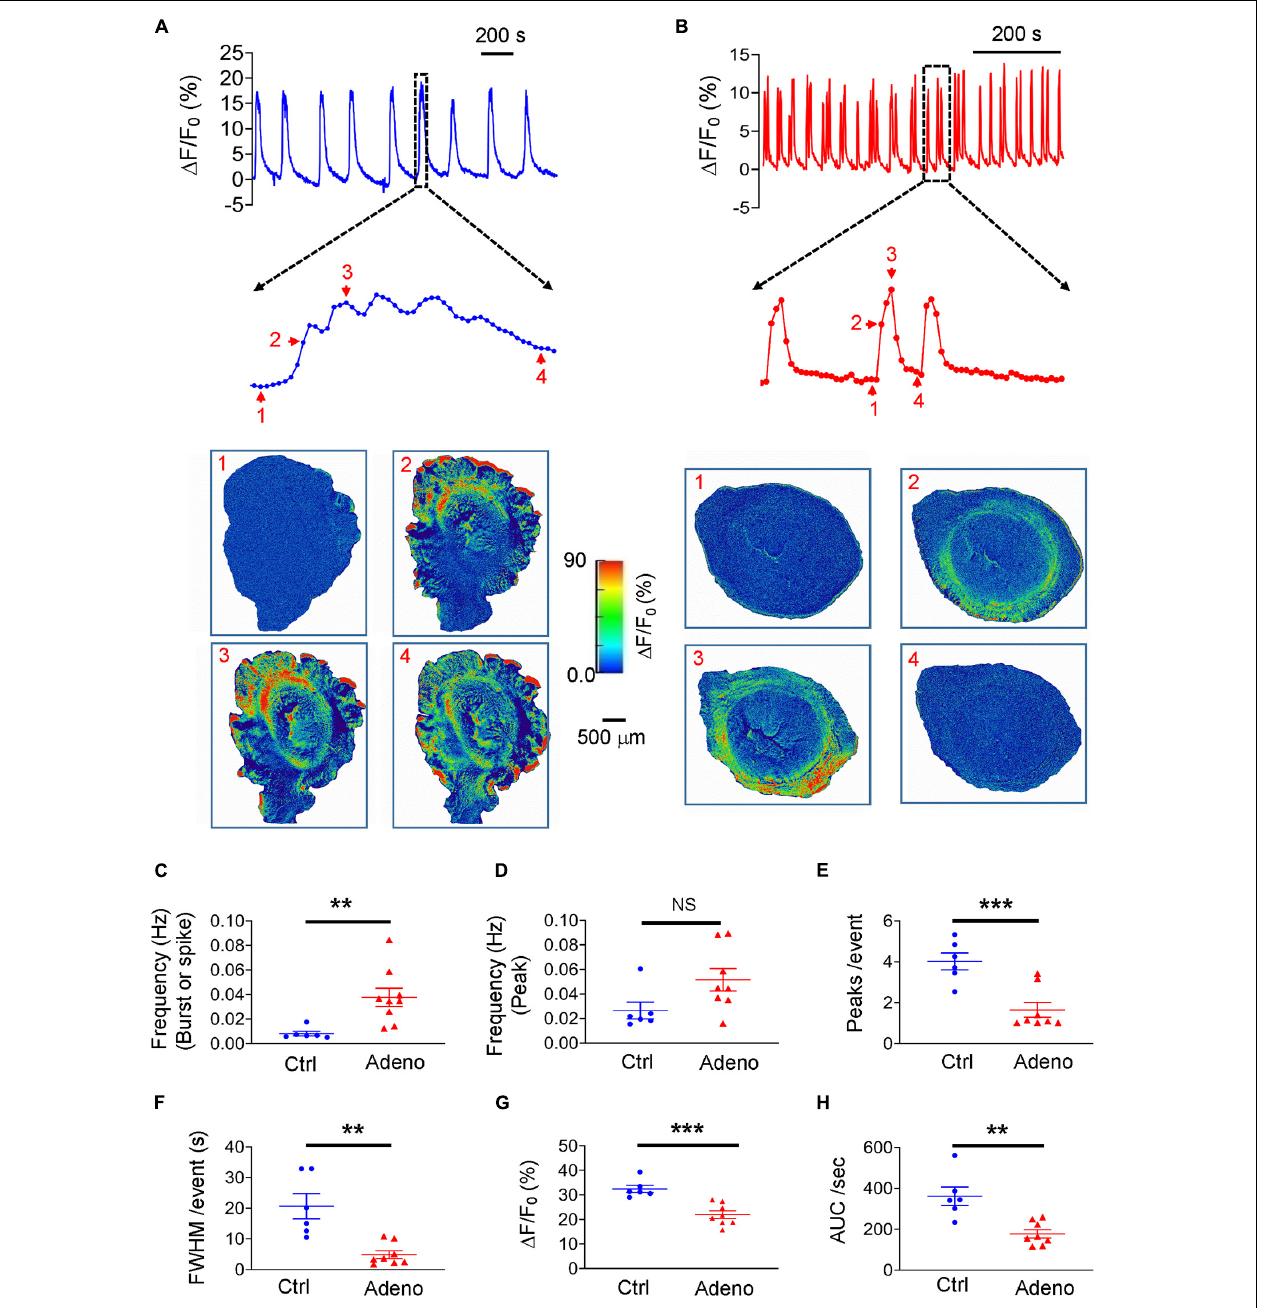
FIGURE 6 | Changes in Ca 2 + oscillations in adult adenomyotic mice. (A) Typical Ca 2 + oscillations in postnatal day (PND) 55 mice after treatment with the vehicle for tamoxifen (Ctrl). A burst event as marked with the dotted line box is shown in an expanded time scale, and images below the trace are snapshots of this event as indicated by the corresponding numbers near the trace. (B) Typical Ca 2 + oscillations in PND55 mice after treatment with tamoxifen. Three events as marked with the dotted line box are shown in an expanded time scale, and images below the trace are snapshots of one of these events, as shown by the corresponding numbers near the trace. (C) Ca 2 + oscillation frequency when a burst or a spike was counted as one event (the same convention is applied to panels E–H ). (D) Ca 2 + oscillation frequency when an individual peak in bursts or spikes was counted as an event. (E) Numbers of Ca 2 + oscillations per event in uterine slices from Ctrl and Adeno mice at PND55. (F) Full width at half maximum (FWHM)/event in uterine slices from Ctrl and Adeno mice at PND55. (G) Amplitude of Ca 2 + oscillations in uterine slices from Ctrl and Adeno mice at PND55. (H) Calcium intensity (AUC × Frequency) in uterine slices from Ctrl and Adeno mice at PND55. Note that each data point in panels (C–H) is an average value from multiple slices in a mouse, and each slice was recorded for 30 min. N.S., no statistical significance, ** P < 0.01, *** P < 0.001 with unpaired Student’s t -test [ N = 6 Ctrl mice (15 slices) and 9 Adeno mice (23–26 slices) for panels C–H ].